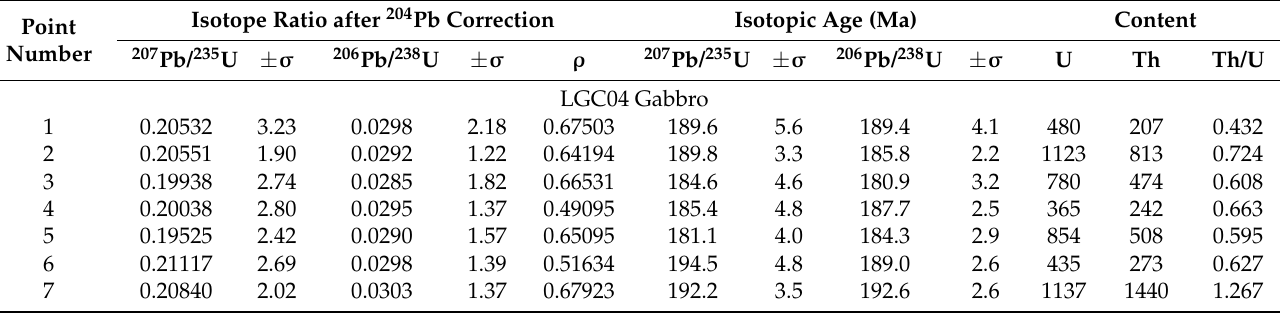
Figure 7. Representative cathodoluminescence (CL) images ( b, d ) and Concordia diagrams ( a, c ) of zircons in the Laguoco gabbro. Red and yellow circles show the locations of U-Pb dating and O isotope analyses with SIMS, respectively. Table 2. SIMS zircon U-Pb data of gabbro, Laguoco,